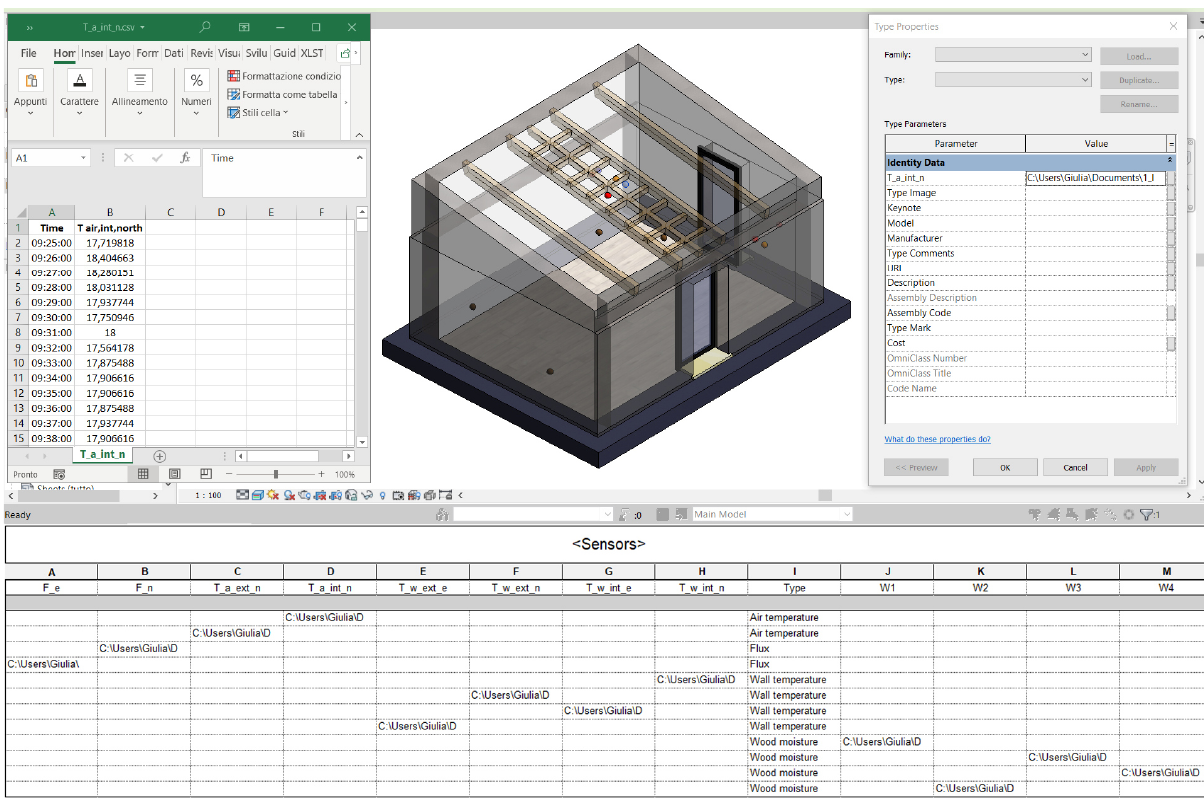
Figure 6. The different spheres have been positioned and colored according to the corresponding sensors in the test room.